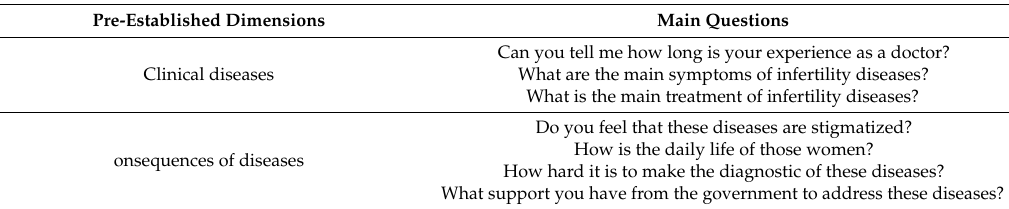
Table 3. Main questions from the interview